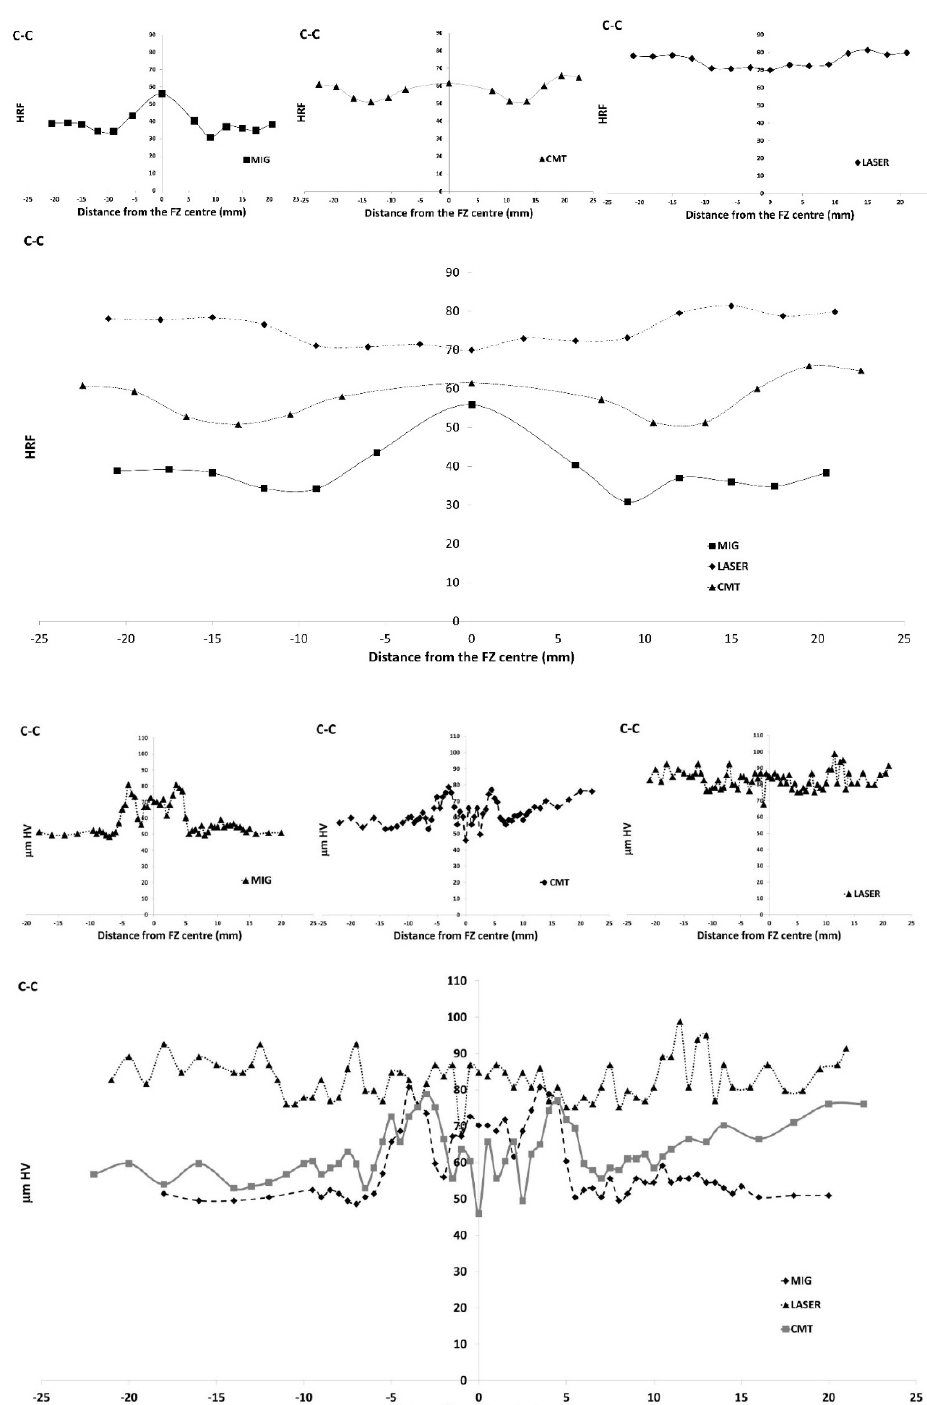
Figure 14. Evolution of the macro-hardness HRF and micro-hardness HV in the C-C combination of the weld for laser, CMT, and MIG.